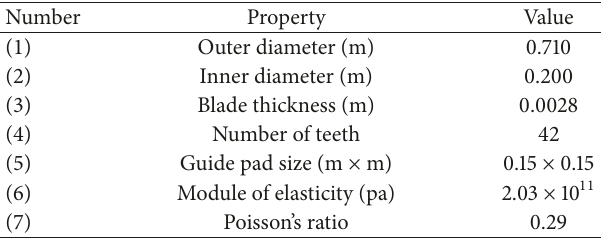
Table 1: Geometrical and physical properties of the guided saw. Number